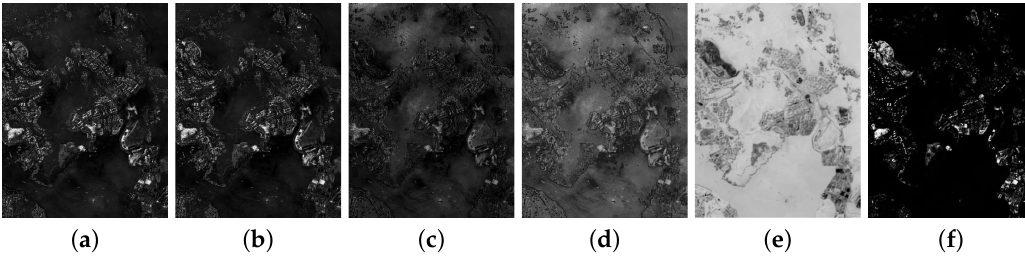
Figure A9. The DIs generated by different methods in the Hongkong data set: ( a ) CVA, ( b ) subtraction, ( c ) log-ratio, ( d ) wavelet fusion, ( e ) SCCN, and ( f ) DADNN.